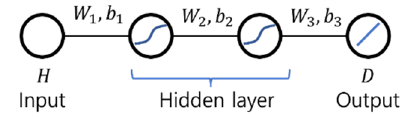
Figure 6. Artificial Neural Network N1.